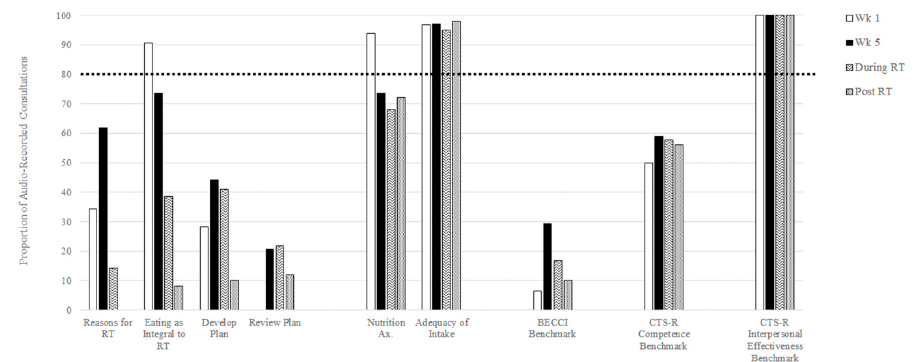
Figure 2. Presence of study specific skills and attainment of fidelity and competence benchmarks within audio-recorded consultations conducted after training in the EAT Intervention.